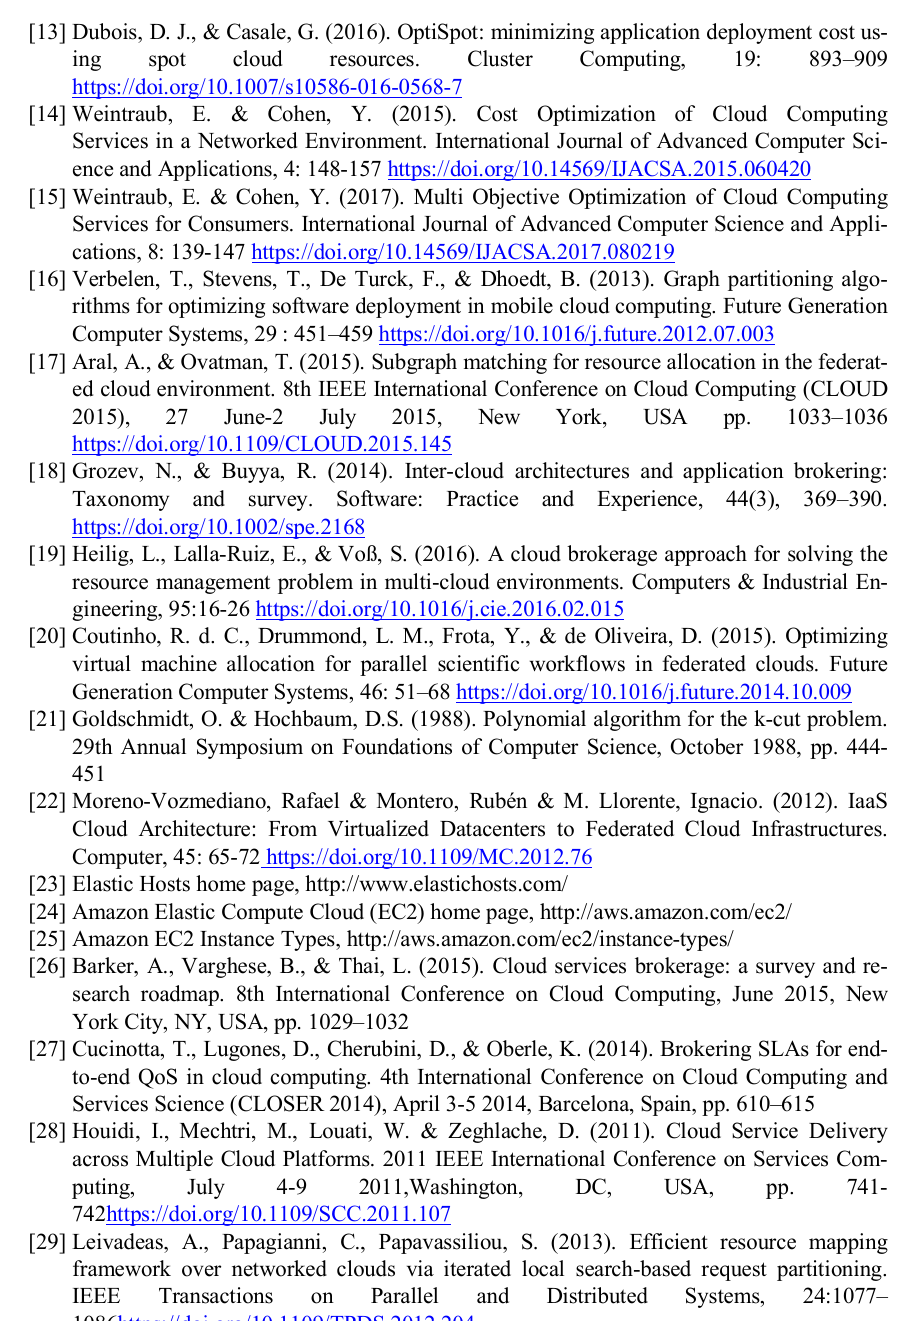
Paper —Efficient and Optimal Service Component Distribution across Multiple